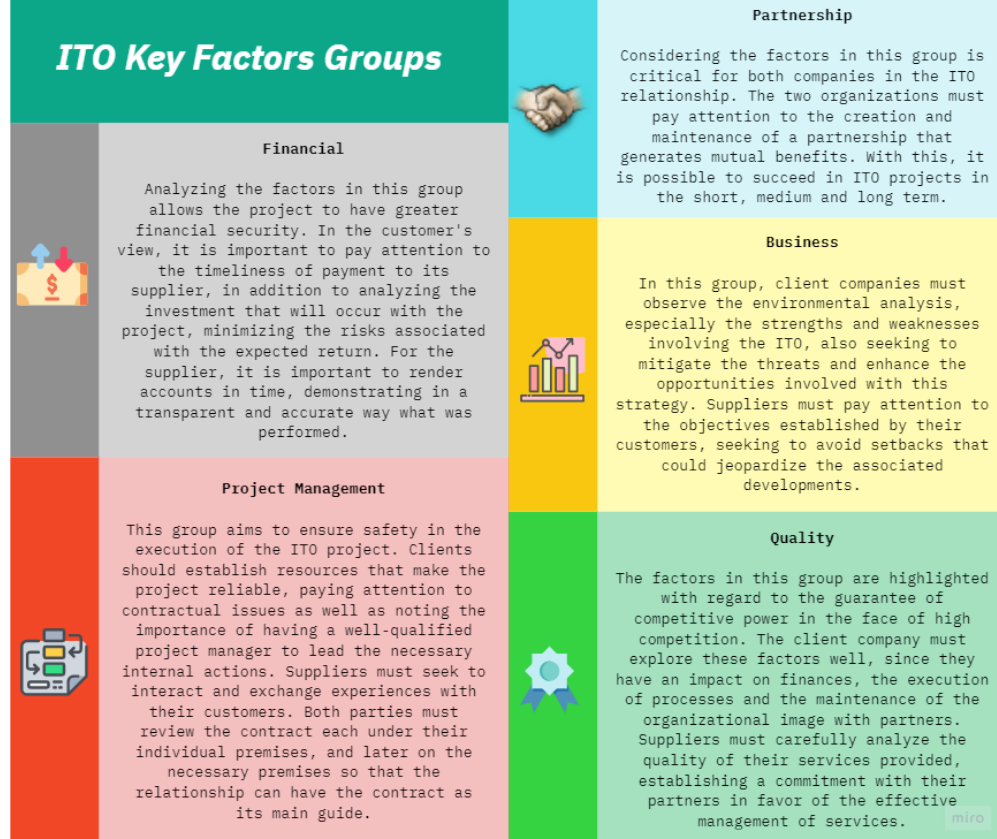
Figure 4. Schematization of factors according to groups with the orders applied internally.